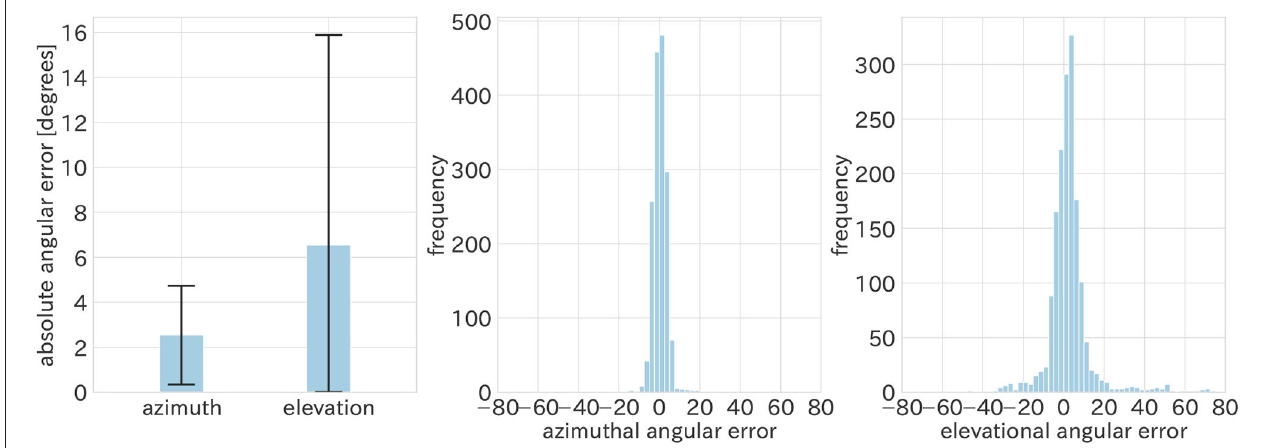
FIGURE 6 | The result of directional guidance pointing accuracy. (Left) Absolute azimuthal and absolute elevational angular error. (Center) A histogram of azimuthal angular error. A bar width indicated 2.5 ◦ . (Right) A histogram of elevational angular error. A bar width indicated 2.5 ◦ .